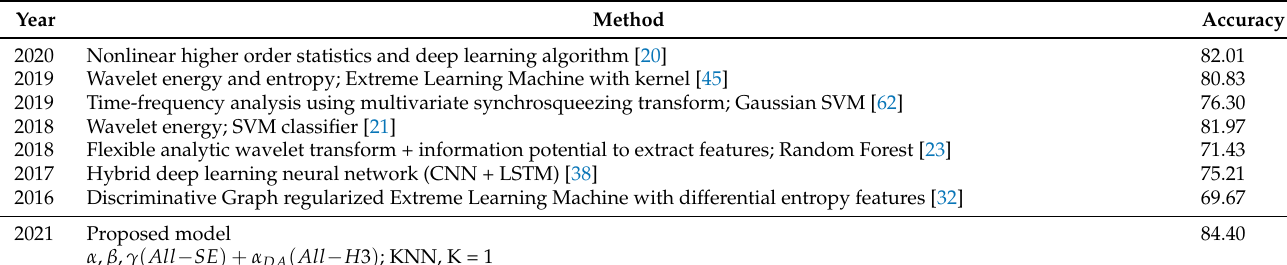
Table 10. Comparison of the accuracy (%) of the proposed model with previous works, for the four quadrants classification. Values are from the original papers and using the DEAP